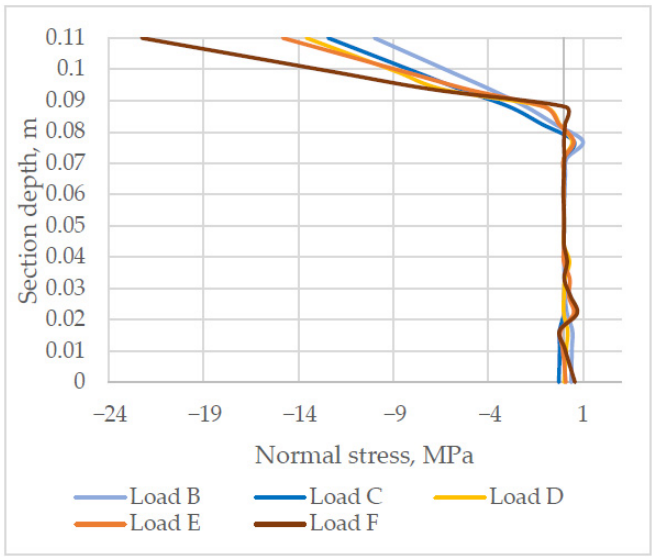
Figure 13. Normal stress distribution in section S YY 2 (negative stress values = compression). In normal section S YY 3 load B causes cracks in the bottom layer of concrete. The top layer takes over all compressive stress. Tensile stress is distributed linearly, and compressive stress distribution takes the form of a parabola. Stress distribution is provided in Figure 14.